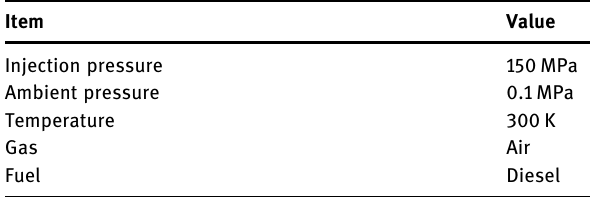
Table 2: Operating conditions